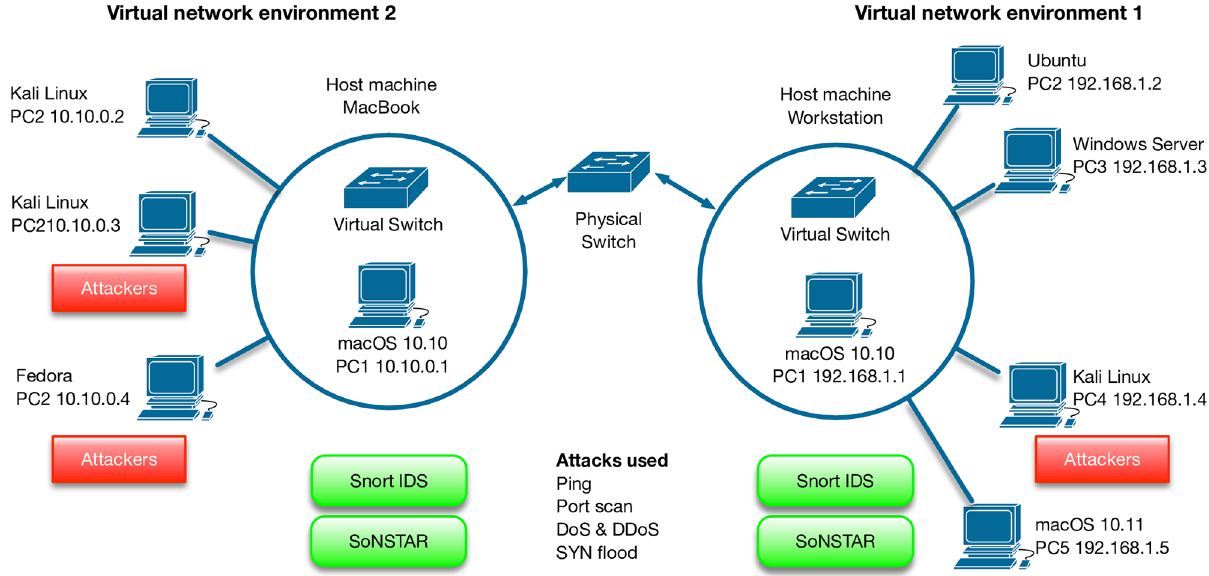
Fig 7. Virtual network environment. The virtual network environment design used in the experiment.